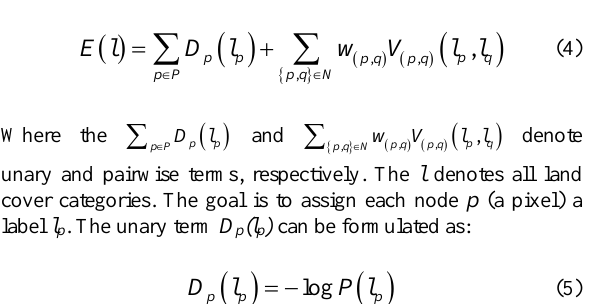
Figure 3. Datasets for